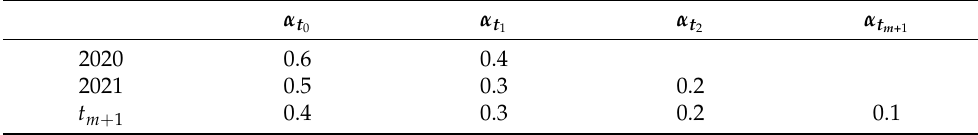
for 2020, 2021 and α t m